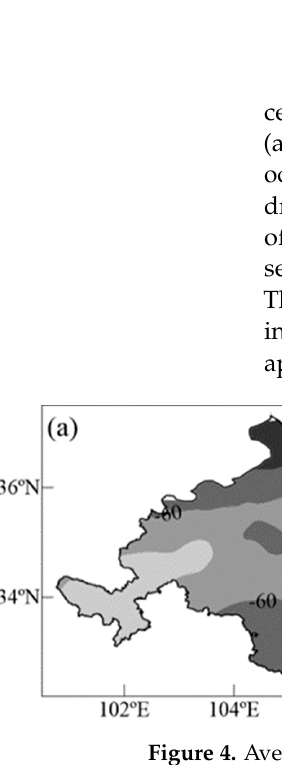
Figure 3. Average ( a ) and longest duration ( b ) of drought processes from 1960 to 2017 (days).